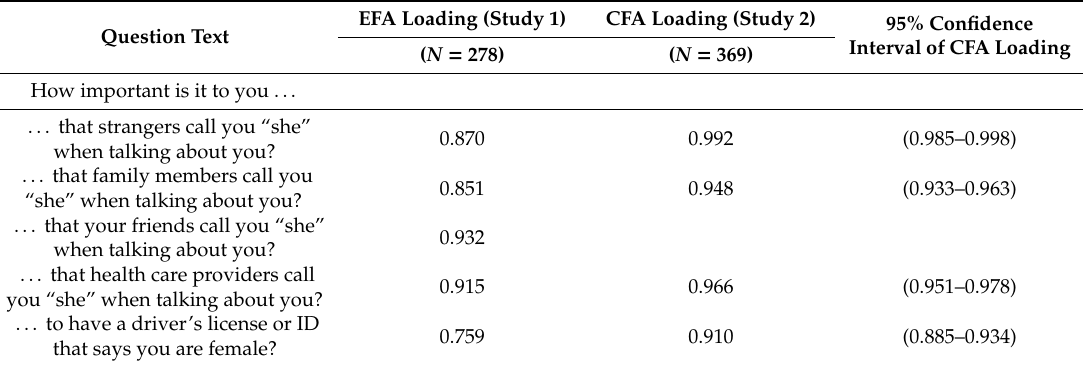
Table 2. Standardized factor loadings from factor